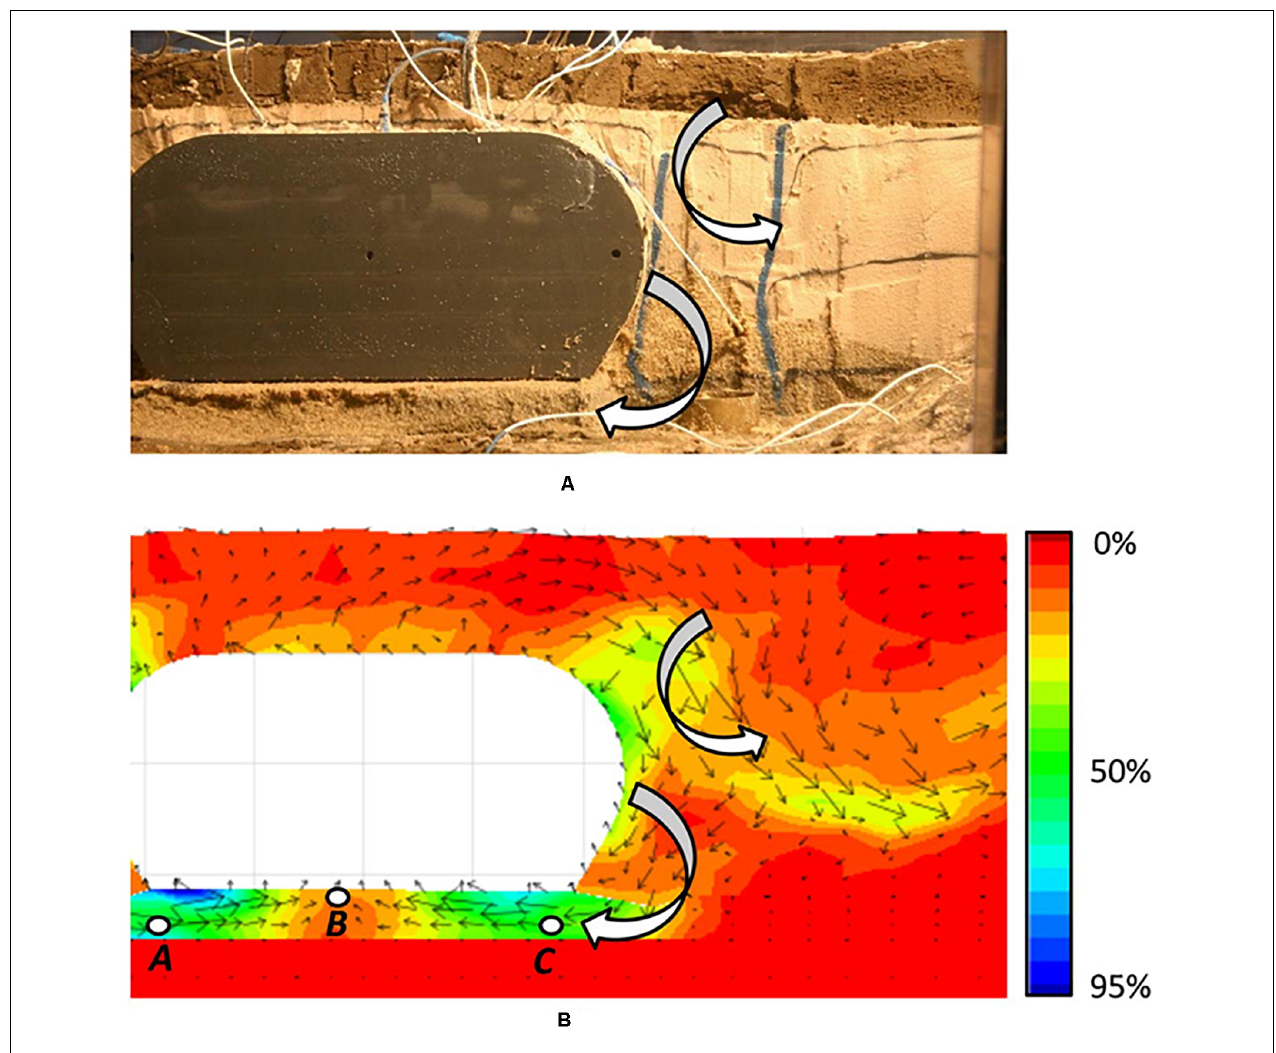
FIGURE 6 | Displacement of sand toward and beneath the tunnel from (A) experimental observation; and (B) numerical analysis. The deformation pattern is illustrated through vertical sand columns for the centrifuge test and displacement vectors and shear strain contours for the numerical analysis (Reproduced from Tasiopoulou et al., 2019 with permission from